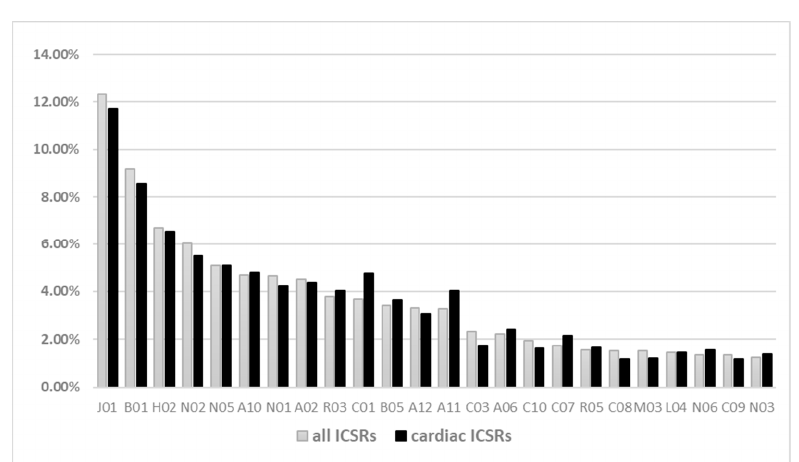
Figure 1. Distribution (not mutually exclusive) of other suspected/concomitant drugs reported in the remdesivir ICSRs. Legend: J01: antibacterials for systemic use; B01: antithrombotic agents;